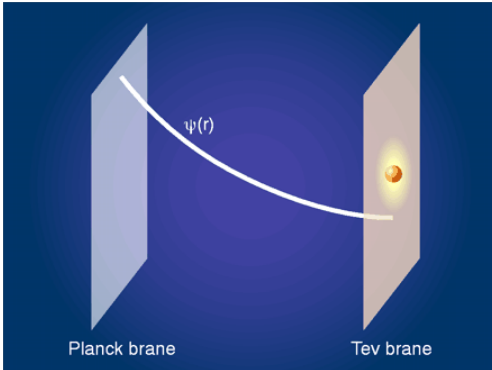
Figure 2: The strong-gravity (Planck brane) and weak-gravity (Tev brane)